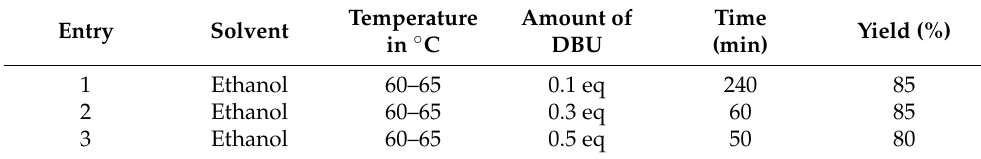
Table 2. Optimization of the amount of DBU a .